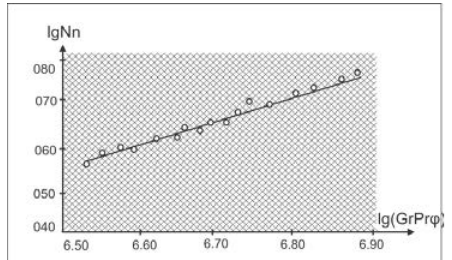
Figure 6. Nusselt criterion dependence on Grashof - Prandtl criterion for liquid flow in flat- plate solar collector